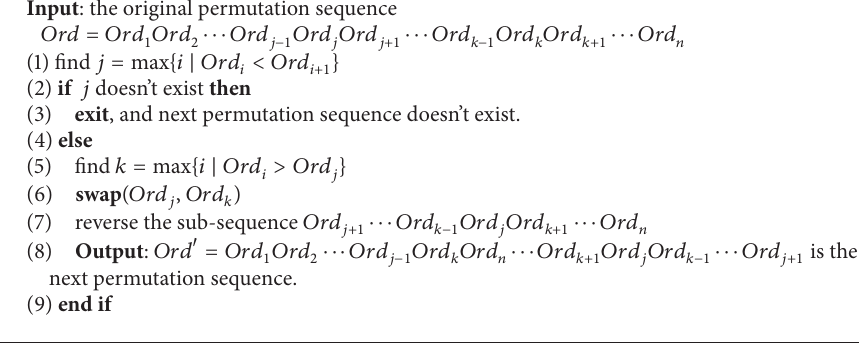
Algorithm 1: next permutation ( Ord ).